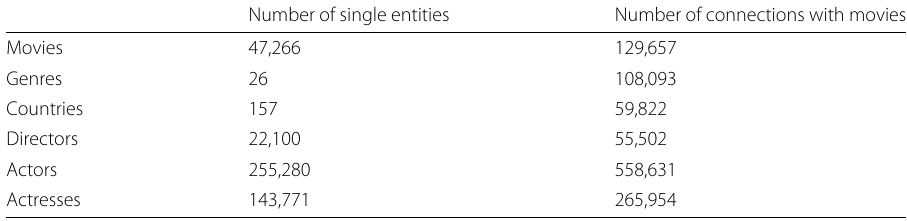
Table 1 Some basic statistics about the dataset of films used for the analysis Number of single entities Number of connections with movies Movies 47,266 129,657 Genres 26 108,093 Countries 157 59,822 Directors 22,100 55,502 Actors 255,280 558,631